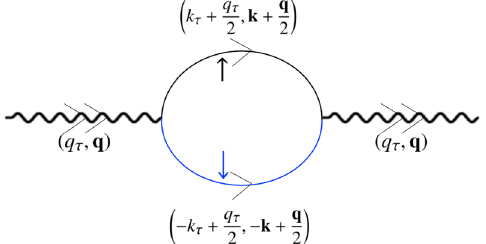
FIG. 9. Imbalanced particle-particle bubble that determines the collective Cooper pair dynamics (the X and Z factors) given in Eq. (9). Generalized to the superfluid phase, fermionic contrac- tions of this form determine the initial values of the Goldstone and longitudinal propagators in the renormalization group flow of Eqs. (5) and (6). Wiggly line is the bosonic Cooper pair propagator, blue straight line is the spin-down fermion propa- gators, and black straight line is the spin-up fermion propagator. The cubic vertex connecting the three is the Yukawa coupling.